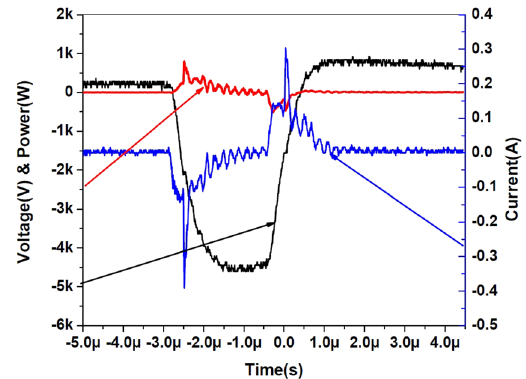
Figure 3. Typical V-I characteristic of the MFP-UV-Lamp.